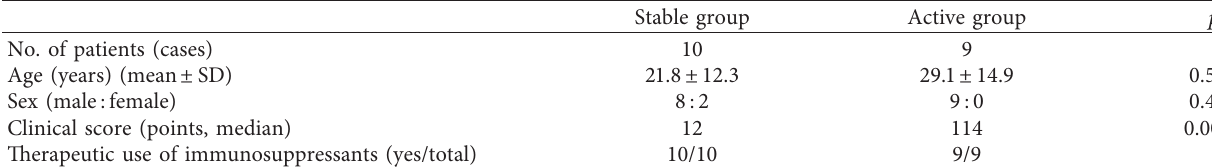
Table 1: Baseline characteristics of included patients.